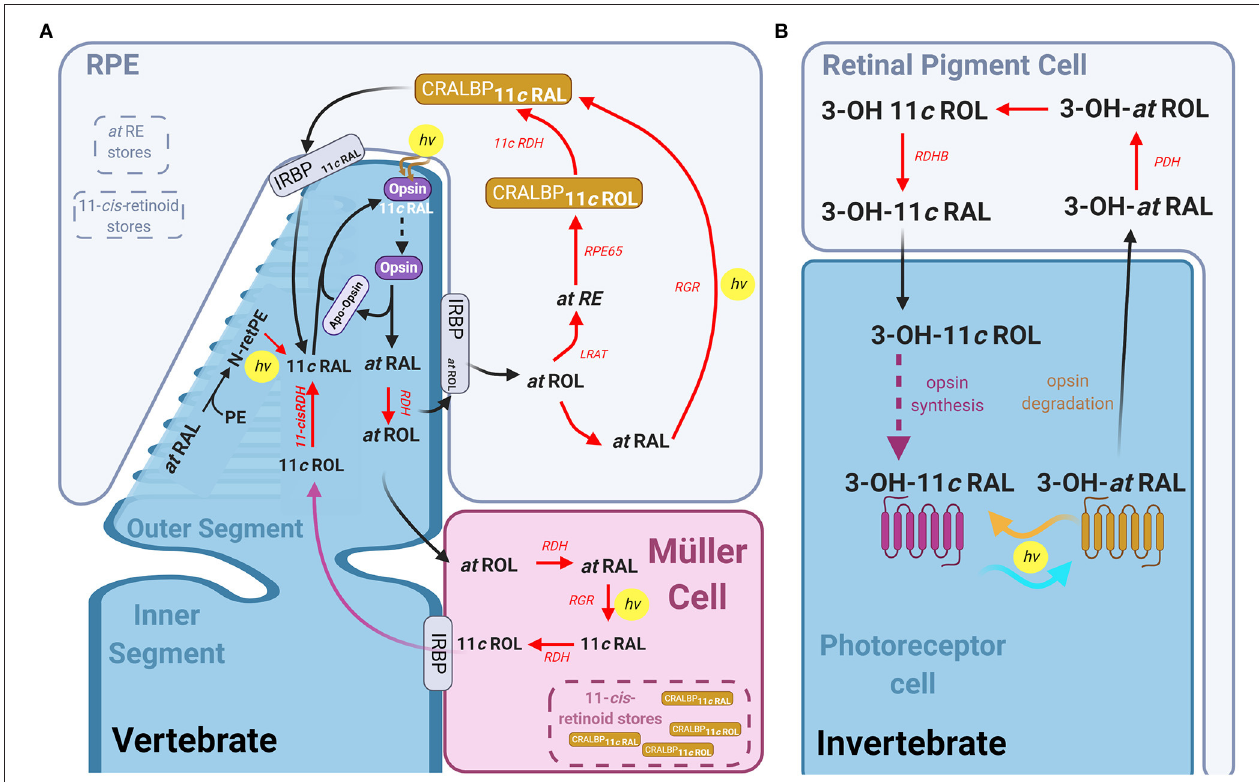
FIGURE 6 | The visual pigment cycle reactions in vertebrate and invertebrate photoreceptors: (A) Pathways for visual pigment regeneration in the vertebrate retina, including both the classical and non-classical pathways. A cone photoreceptor (dark blue) and its’ interactions with the muller glial cells (magenta) and Retinal pigment epithelium (RPE, light blue). Red arrows with red text annotation indicate enzyme mediated reactions and their respective enzymes. The classical pathway occurs via the RPE, all- trans -retinol is taken up by IRBP into the RPE, where LRAT, RPE65, and 11- cis -RDH mediates its conversion to 11- cis -retinal which is then taken up by the photoreceptor via IRBP again, which reassociated with the apo-opsin. The intrinsic light mediated pathway combining all- trans -RAL with phosphatidylethanolamine (PE) to form all- trans -N-retinyl-PE (N-retPE), which is then converted to 11- cis- retinal via a blue photon. Light mediated pigment regeneration can occur both in Müller cells and RPE, whereby all- trans retinal is converted to 11- cis retinal mediated by RGR opsin and the absorption of a photon. Stores of 11- cis -retinoids as well as all- trans -RE are present in both the RPE and Müller cells. (B) Summary of the visual pigment cycle in invertebrates. The invertebrate visual pigment, 3-OH 11- cis retinal is a bistable pigment, and remains associated to the opsin, upon absorption of a second photon, it can convert back from 3-OH all- trans retinal to 3-OH 11- cis retinal. An external pathway is only required in conditions in which the animal is calorie restricted. This pathway is mediated by the retinal pigment cells that surround the rhabdomeres and involves the Photoreceptor retinol dehydrogenase (PDH) and retinol dehydrogenase B (RDHB)